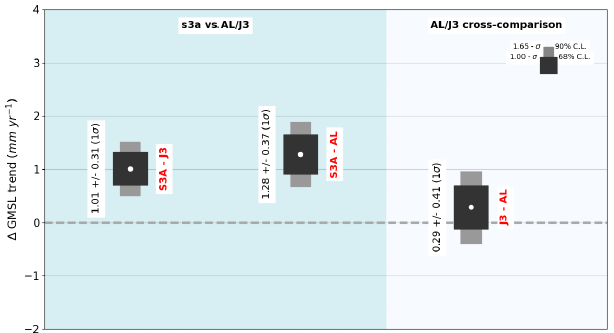
Figure 2. GMSL trend differences between S3A and Jason-3 and between S3A SARAL/AltiKa over the July 2016 to March 2021 period. The black boxes show the GMSL trend uncertainties at 68%CL, and the grey boxes show the GMSL trend uncertainties at